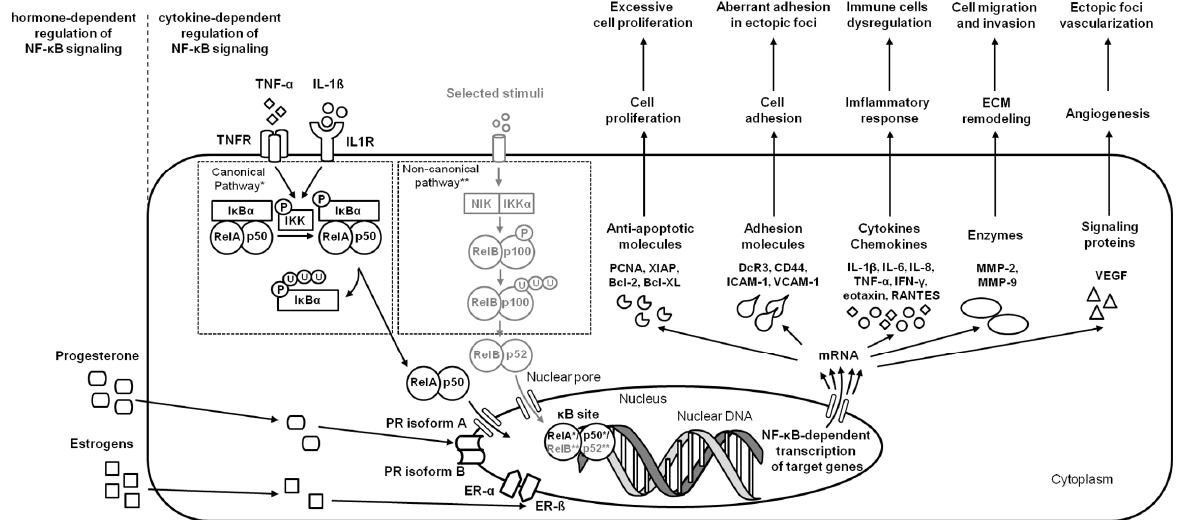
Figure 2. A simplified schema of the NF- κ B signaling pathway in the endometrium in the case of endometriosis. Studied pathways are marked in black. Pathways requiring further research are marked in grey. Both canonical pathway * and noncanonical pathway ** are considered.